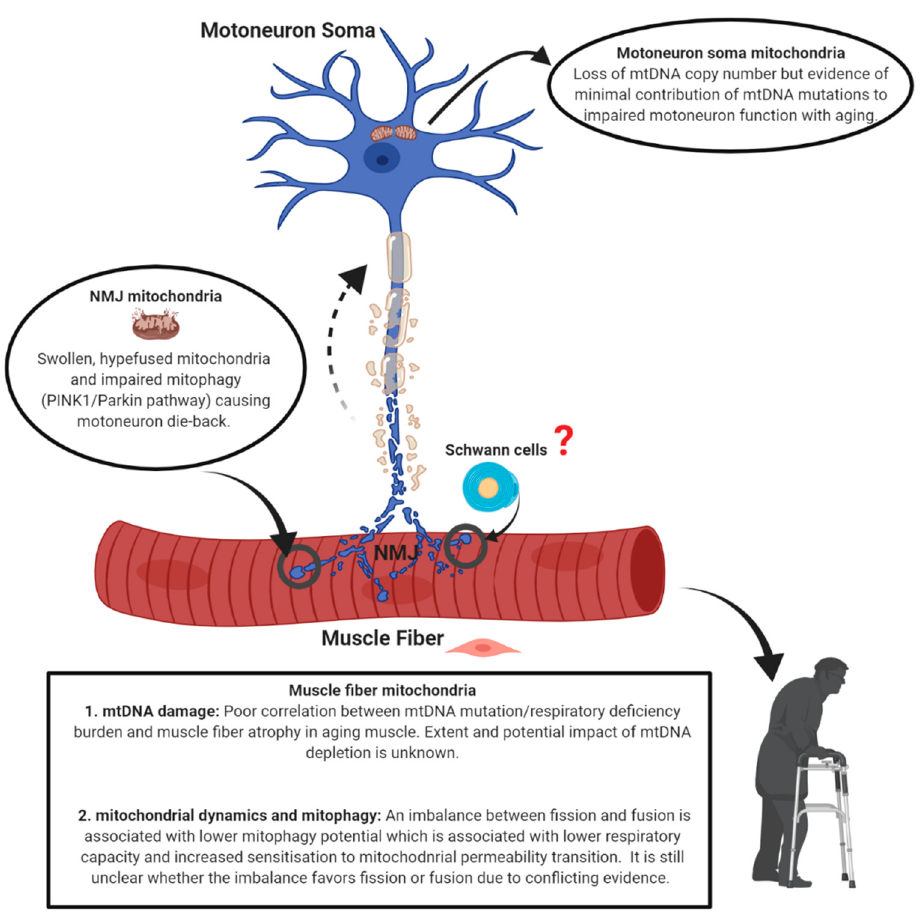
Figure 9. Schematic summarizing the global changes in mitochondria within skeletal muscle fibers and motoneurons with aging.